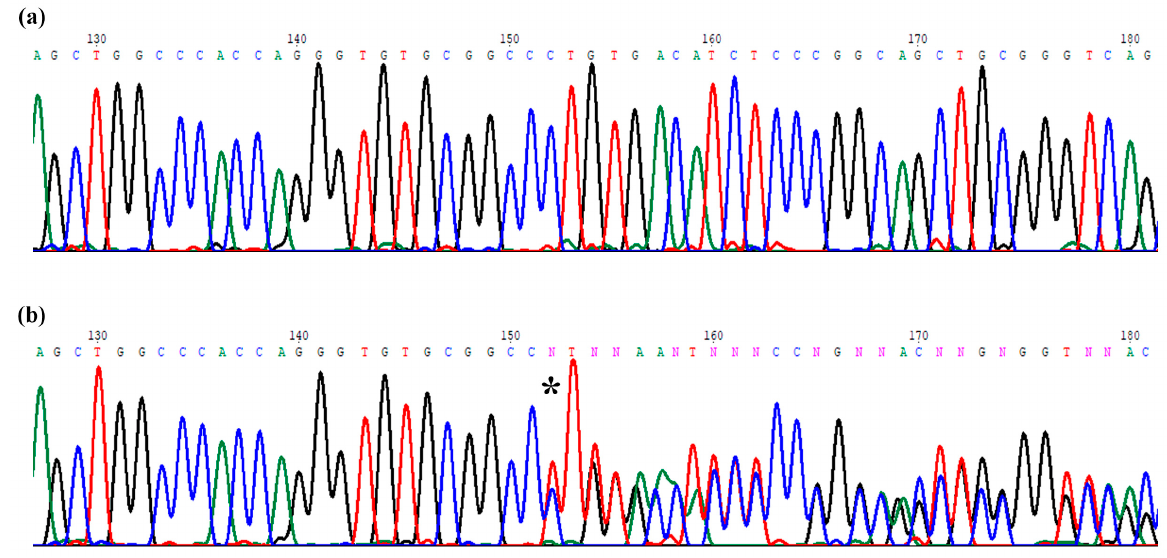
Figure 4. Chromatograms related to the sequence variation indel c.153_155delCTGinsTT. ( a ) the forward sequence of exon 2 wild type. ( b ) the forward sequence with the variations: the star (*) indicates the starting CTG nucleotides deletion and the TT insertion.